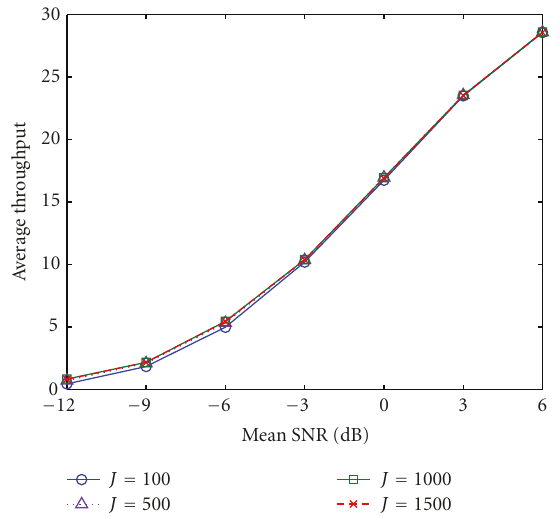
Figure 6: The average throughput of the regression-based policy for di ff erent numbers J of simulated